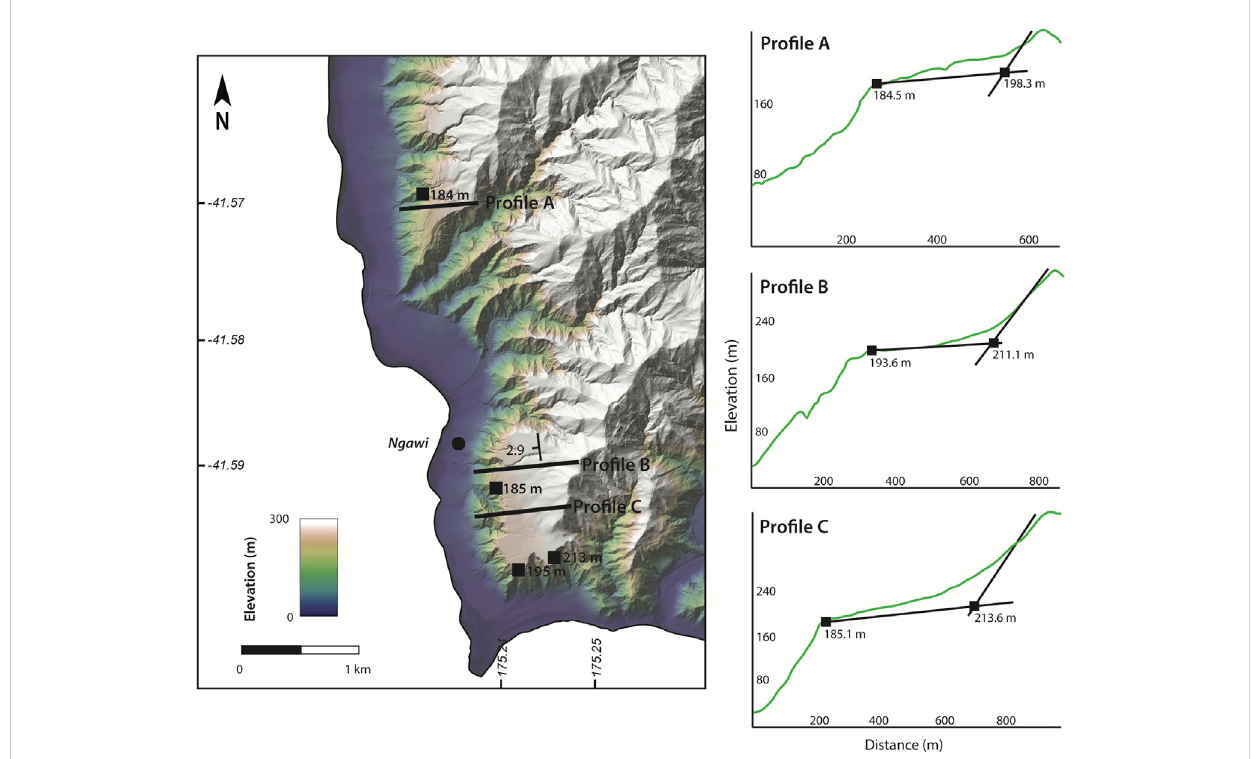
FIGURE 5 Late Pleistocene marineterraces atNgawi, near CapePalliser,showing shoreline angle elevation pro fi les reconstructions-Pro fi les (A – C) - on a 1 m lidar shaded hillslope model (courtesy